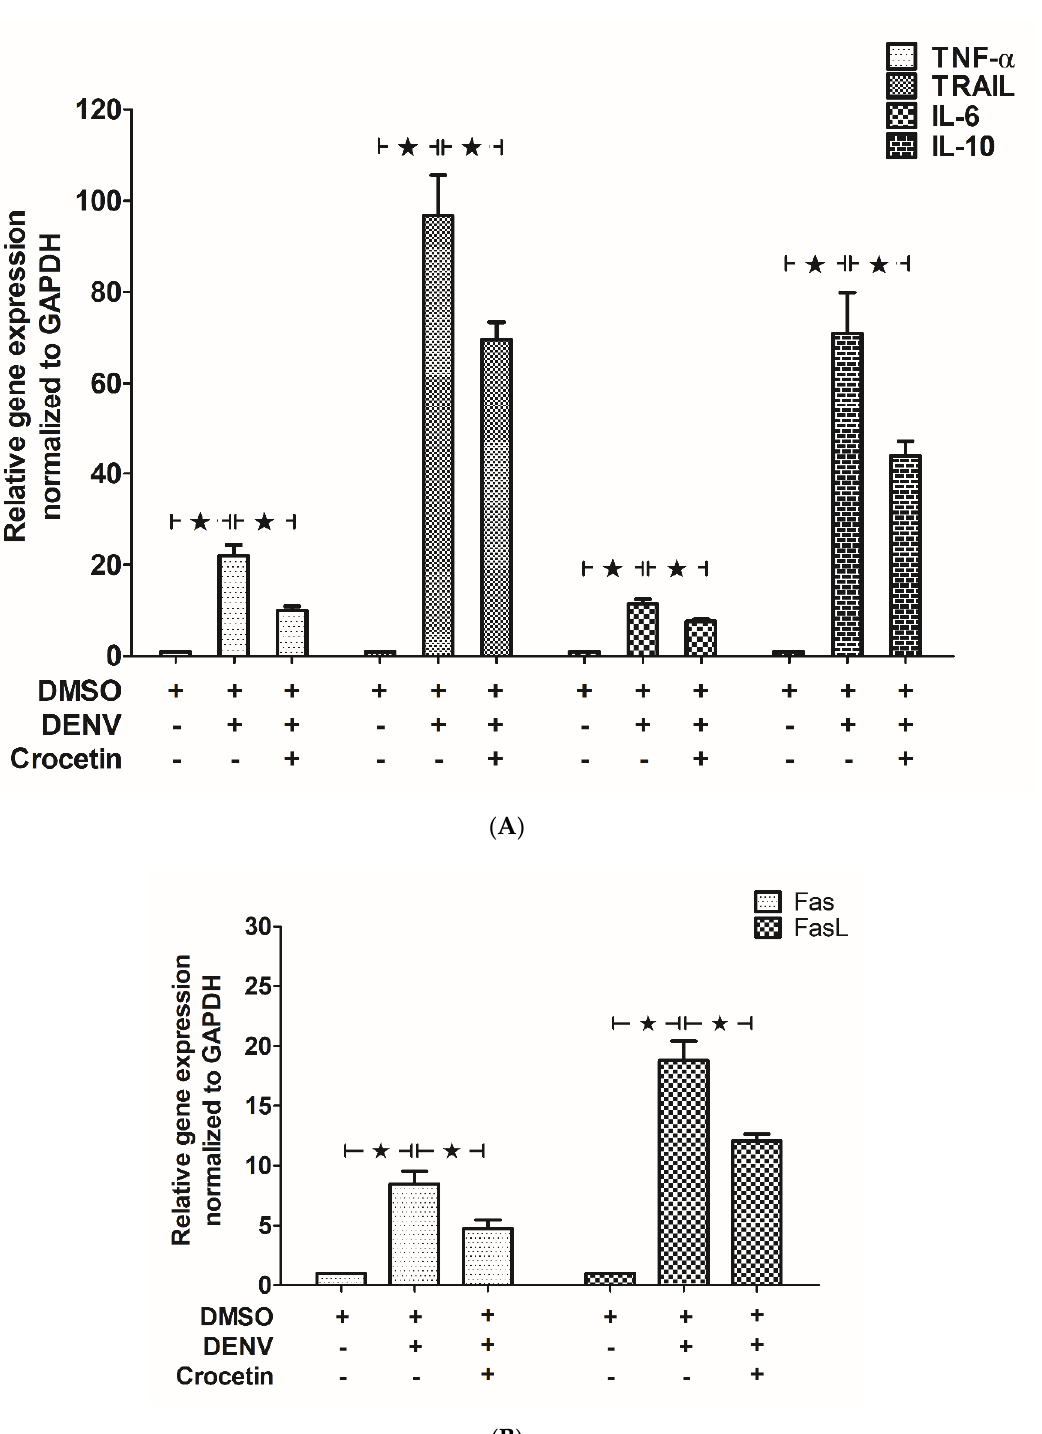
Figure 4. Crocetin reduced the expression of inflammatory cytokines and pro-apoptotic mediators in the livers of DENV-infected mice. BALB/c mice were infected with DENV-2 (4 × 10 5 FFU/mL) and then treated with crocetin (50 mg/kg) dissolved in 2% DMSO. DENV-infected 2% DMSO-treated and mock-infected 2 % DMSO-treated groups of mice were used as positive and negative controls, respectively. RNA samples prepared from liver tissues were converted to cDNA. RT-PCR was conducted, and the Ct values were normalized to that of GAPDH. The mRNA expressions of ( A ) TNF- α , TRAIL, IL-6 and IL-10, and ( B ) Fas and FasL , are shown. The black star represents, those groups were compared and found to be significant.